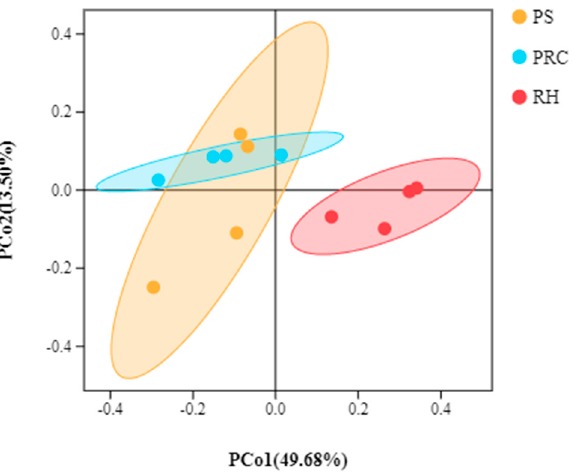
Figure 3. Principal coordinates analysis (PCoA) plot of colostrum samples. PS = peanut shells, PRC = peanut–rice combination, RH = rice husks. Overlap within two habitats indicated that exposure to different bedding types had similar bacterial community compositions of colostrum samples, if not the bacterial community was different.